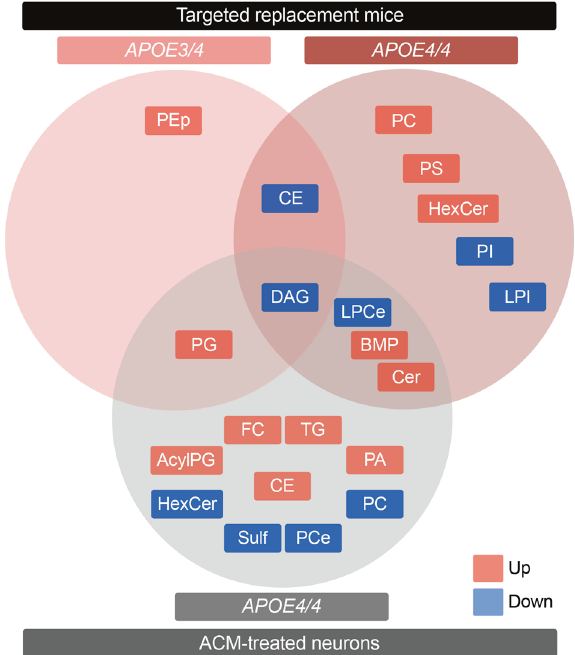
Fig. 4 APOE isoform expression differentially modulates lipid pro fi les. Venn diagram generated from lipid species signi fi cantly altered in the EC in APOE4/4 and APOE3/4 targeted replacement mice versus APOE3/3 mice (upper row) and in WT cortical neurons treated with APOE4/4 versus APOE3/3 ACM (lower row). Only lipid classes are represented; refer to Figs. 1 – 3 for speci fi c lipid acyl-chain composi- tion per class, respectively. Red denotes increased levels; blue denotes decreased